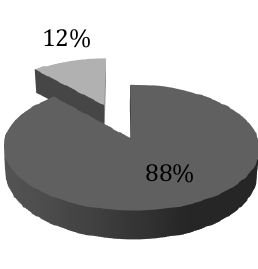
Fig. 5. Students satisfaction with the new